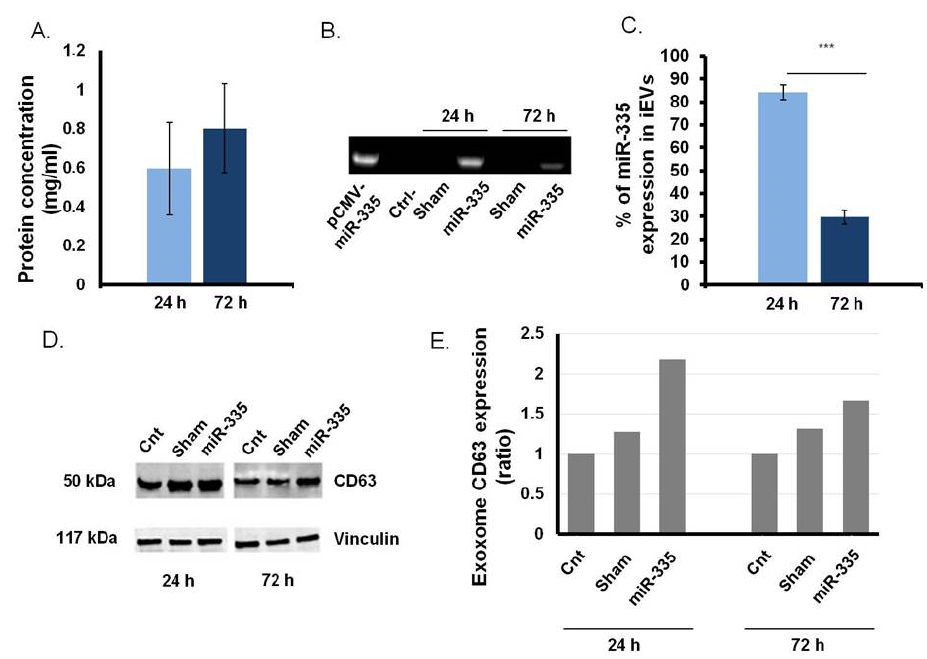
Figure 4. Analysis of B cell-derived iEVs. ( A ) iEVs production estimate as protein concentration at 24 and 72 h. B cells were stimulated, or not, using FuGene HD transfection agent. iEVs were collected from the B cell growth medium using a separation kit as indicated in the Material and Methods. Protein concentration determined by subtracting the values in unstimulated cells from the stimulated ones. ( B ) Detection of miR-335 in iEVs from transfected B cells vs. vesicles from untransfected B cells. ( C ) Densitometry quantitation (percentage over vesicles from untransfected cells as control) of miR-335 in iEVs from transfected cells ( p < 0.0005 = *** by t -test). ( D ) CD63 ex-pressZion on iEVs by Western blot analysis. ( E ) Western blot quantification of CD63. Vinculin, a housekeeping gene, was used for normalization (see Materials and